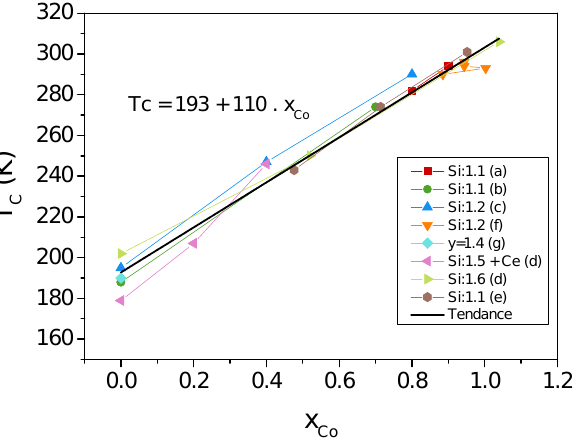
Figure 2. Curie temperature evolution of compounds for which Fe has been partially substituted by Co (a) [46], (b) [47], (c) [48], (d) [49], (e) [18], (f) [50], (g) [21], and (h) [51].